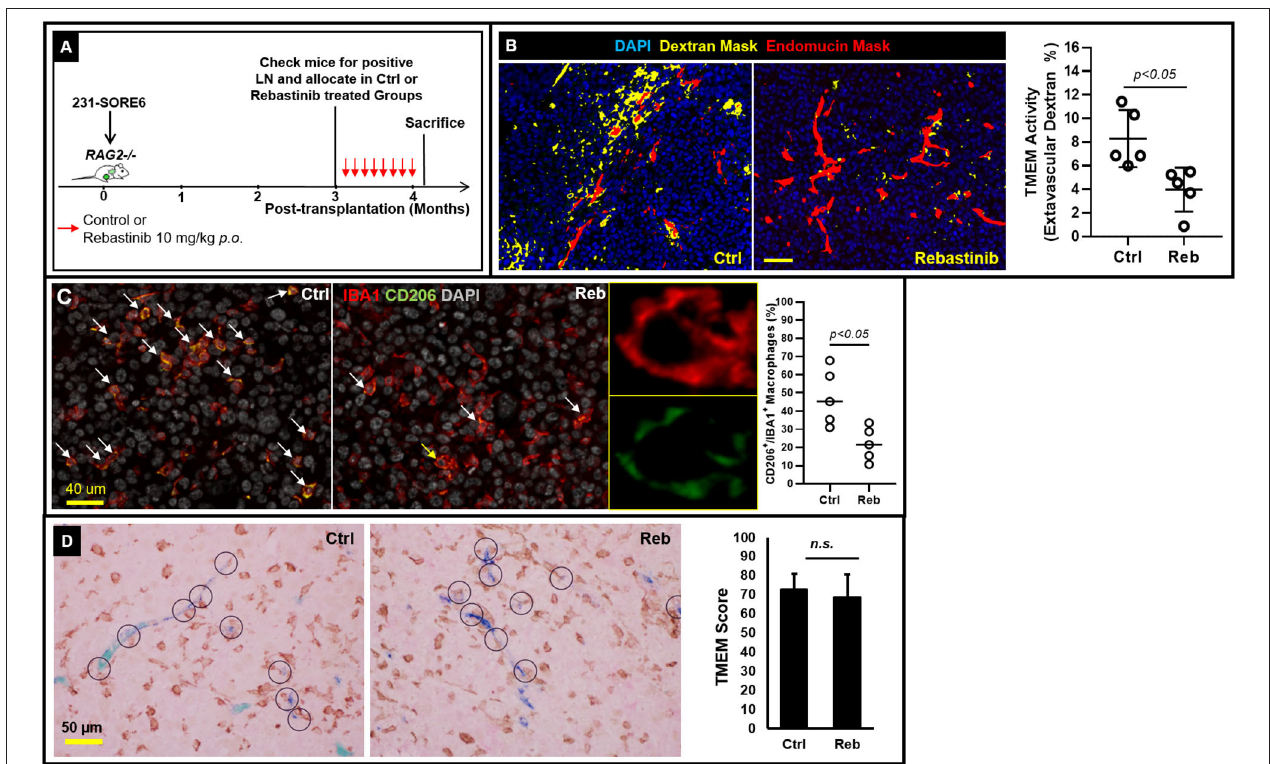
FIGURE 2 | TMEM doorways in established lymph node metastases mediate vascular permeability for cancer cell re-dissemination to tertiary sites. (A) Experimental design of control and rebastinib-treated animals with established lymph node metastases. (B) Left: Representative examples of the extravascular dextran assessment using multichannel immunofluorescence imaging in 231-SORE6 mice treated with either vehicle (left) or rebastinib (right). Right: Quantification of extravascular dextran area (%) in control and rebastinib-treated mice (Mann–Whitney U -test, p < 0.05) shows a significant reduction in TMEM-mediated vessel leakiness upon treatment with rebastinib (Reb). (C) Left: Formalin-fixed paraffin-embedded sections of lymph node tissue with established metastatic nodules was stained for the macrophage specific marker IBA1 and the M2-polarization marker CD206, and the CD206 + IBA1 + macrophages (pointed with the arrows) were scored as a proportion of the total IBA1 + macrophages in vehicle-treated (Ctrl; left panel) and rebastinib treated (Reb; right panel) 231-SORE6 xenografts. Nuclei were counterstained with DAPI. Snapshots are representative images from the experimental groups. Middle: Magnification of the macrophage shown with the yellow arrow in the right image on the rebastinib-treated example image on the left confirms co-expression of IBA1 and CD206 on the same macrophage. Right: Quantification of CD206 + IBA1 + macrophages in the images shown on the left. (D) Left: Representative examples of formalin-fixed paraffin-embedded sections of lymph node tissue with established metastatic nodules stained for TMEM triple-IHC stain and scored in vehicle-treated (Ctrl; left panel) and rebastinib-treated (Reb; right panel) 231-SORE6 xenografts. Right: Quantification of TMEM scores in the images shown in the Left. n.s.,